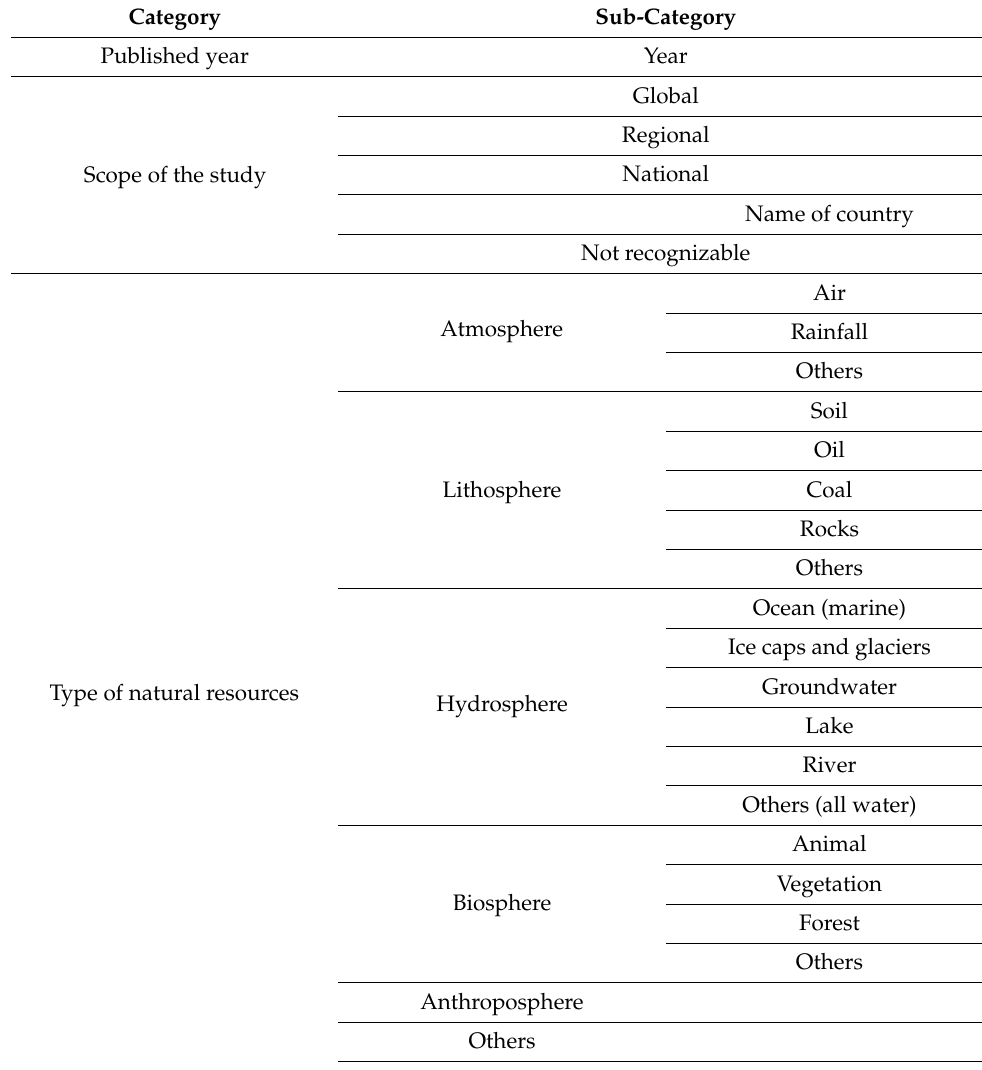
Table 2. Coding category